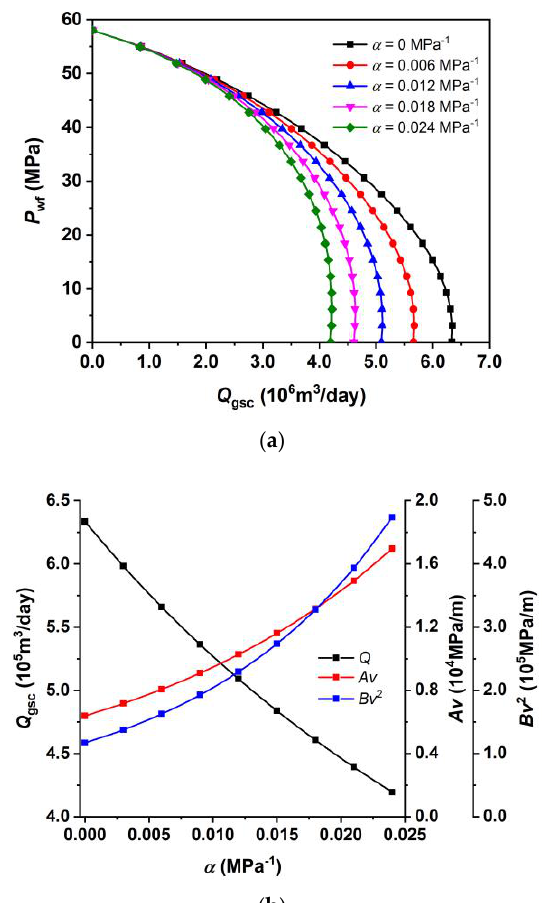
Figure 10. Effect of stress sensitivity coefficient on gas production rate and flow characteristics. ( a ) IPR curves with different stress sensitivity coefficient. ( b ) Characteristic analysis of flow regime at the well bottom hole.